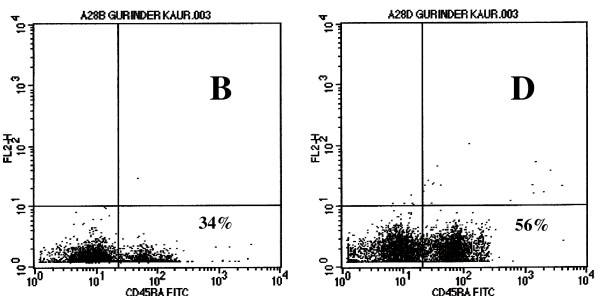
Flowcytometric analysis of CD45RA+ Naïve T cells in patient with low CD4 counts. FL 1 shows FITC labeled CD45RA+ naïve T lymphocytes. Note an increase of CD45RA + naïve T cells from 34% at stage B to 56% at stage D.